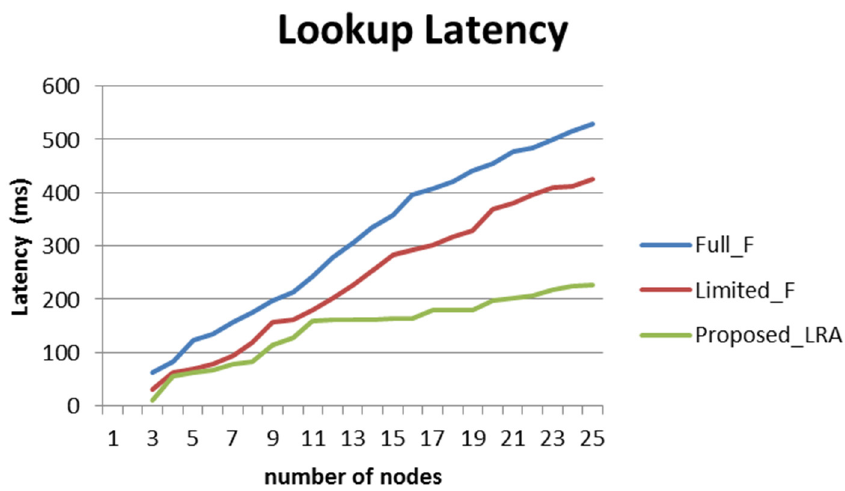
Figure 13. Comparison of lookup latency with the different algorithms.